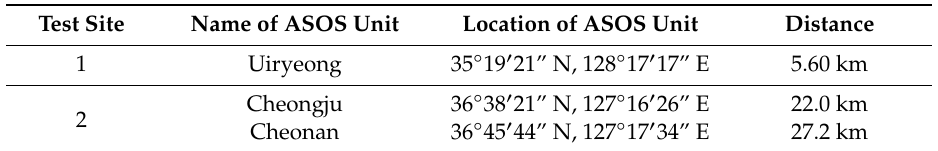
Table 14. Detailed location of automated surface observing system (ASOS) units and their distance to test site locations. The name of each ASOS unit signifies its geographic location. The distance refers to the straight distance between the ASOS unit and the given test site.